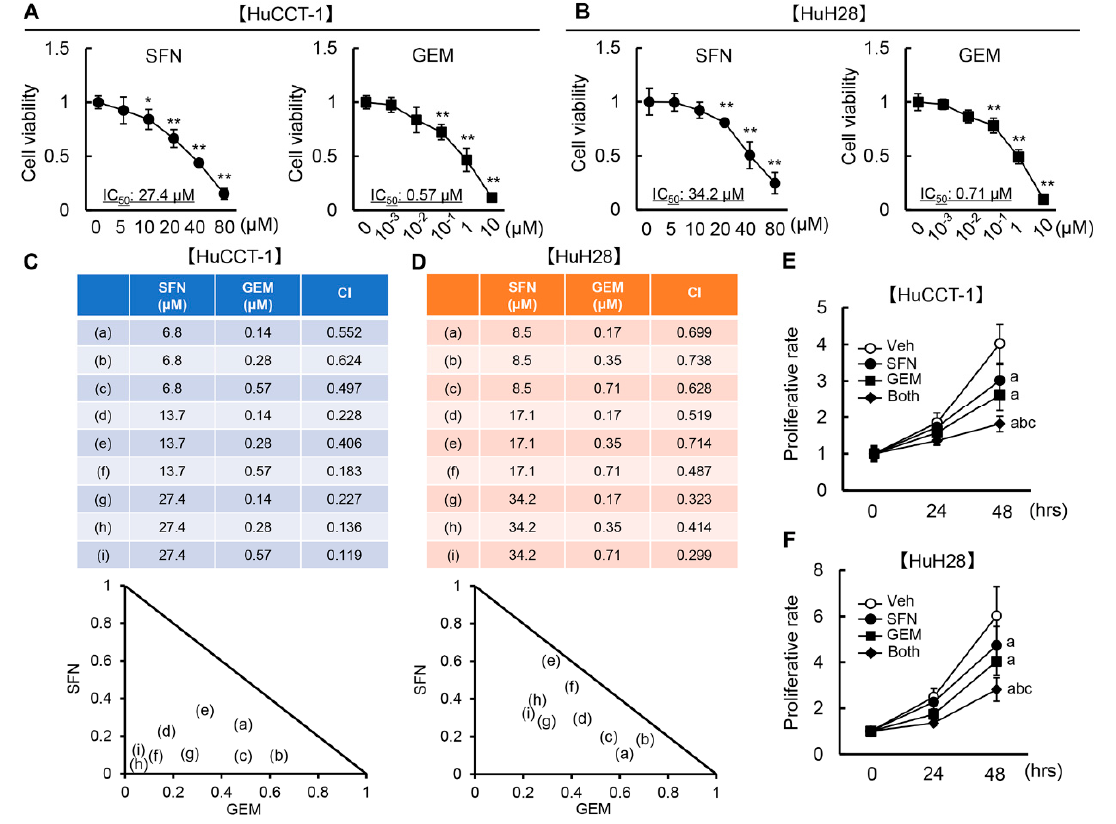
Figure 2. Cell viability and proliferation by treatment with SFN and GEM in iCCA cells. ( A , B ) Cell viability and IC50 in HuCCT–1 ( A ) and HuH28 ( B ) cells treated with SFN (0–80 µ M) or GEM (0–10 µ M). ( C , D ) The synergism of SFN and GEM on HuCCT–1 ( C ) and HuH28 ( D ) was evaluated by the combination index (CI) values. CI gives a quantitative definition of synergism (CI < 1), additive effect (CI = 1), and antagonism (CI > 1) ( E , F ). Cell proliferation of HuCCT–1 and HuH28 cells incubated with SFN and/or GEM at each IC50 for 0–48 hrs. The values are shown as fold changes relative to 0 µ M for each treatment group ( A , B ) and the values at the start of each treatment ( E , F ). Data are mean ± SD ( n = 3 independent experiments with n = 8 samples per condition) ( A , B , E , F ). * p < 0.05, ** p < 0.01 compared with the values of 0 µ M for each treatment group ( A , B ). a p < 0.01, b p < 0.01, c p < 0.01 compared with the group treated for 48 h with Veh, SFN or GEM, respectively ( E , F